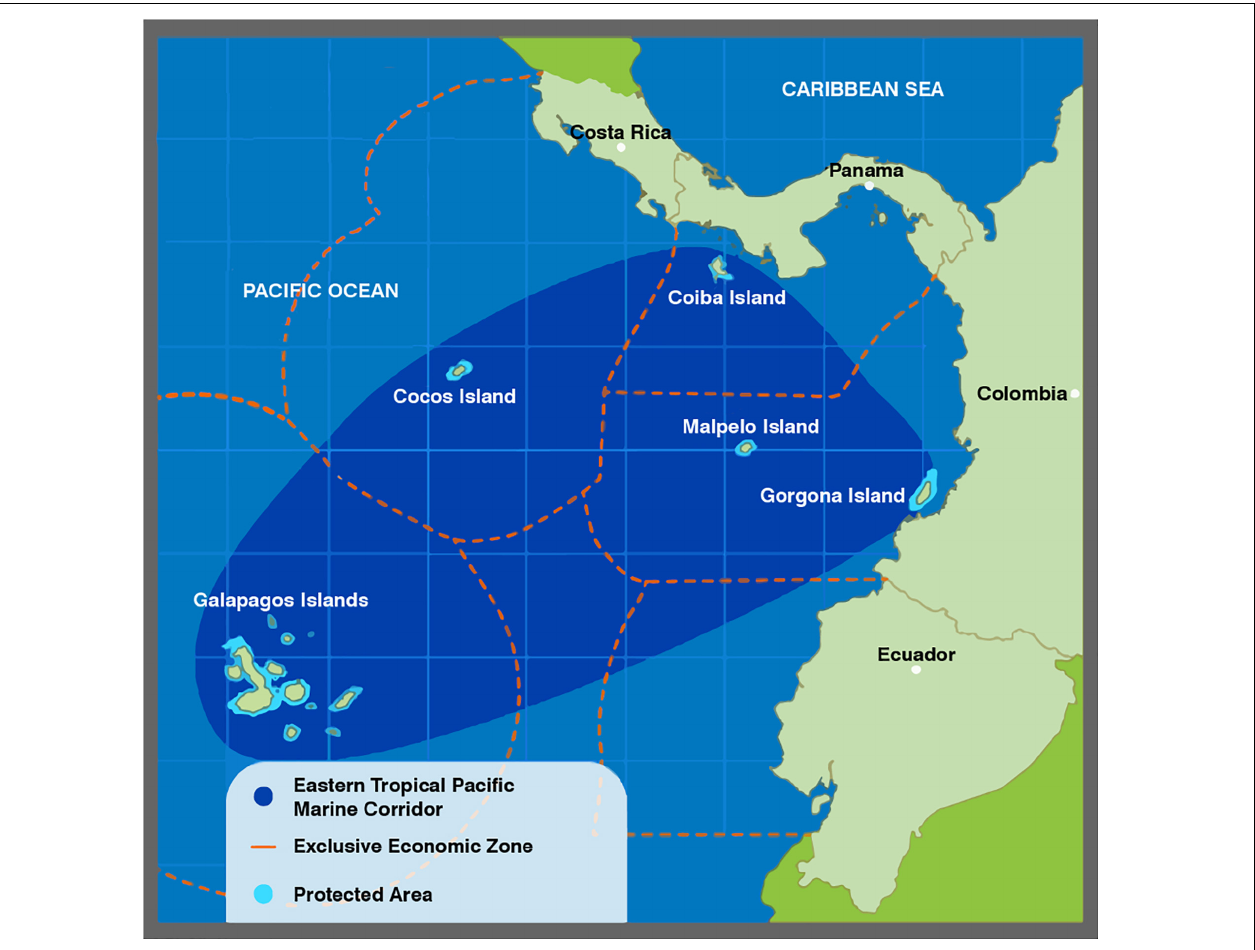
FIGURE 1 | Proposed Eastern Tropical Pacific Marine Corridor (CMAR). This map was designed by the MarViva Foundation in 2005 as a tool to visualize the area which could eventually be delimited as the marine corridor. The official geographic delimitation of CMAR remains pending. Available at